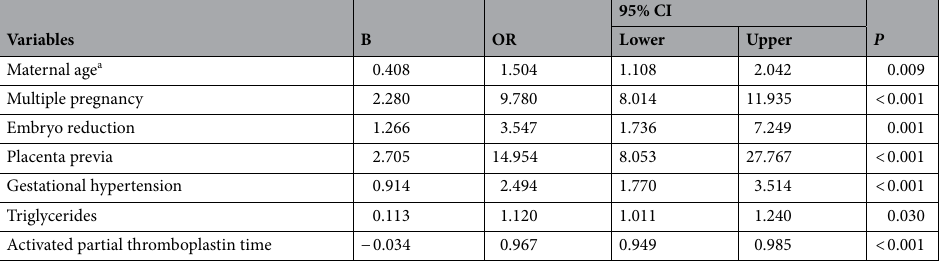
Table 4. Stepwise multivariate logistic regression analysis comparing mothers with preterm and full-term births. Fourteen factors showing significant differences in the univariate analysis (see also Tables 1, 2, 3) were entered into the stepwise multivariate logistic regression analysis. Full-term birth group was termed as the reference group of dependent variate. The following seven factors showed no significant effect on preterm birth in the stepwise multivariate logistic regression analysis: Apolipoprotein B, total cholesterol, low density lipoprotein, gestational diabetes, embryo transfer type, number of embryos transferred, and offspring sex. a Maternal age: 40 or 20–24 vs. 25–39.